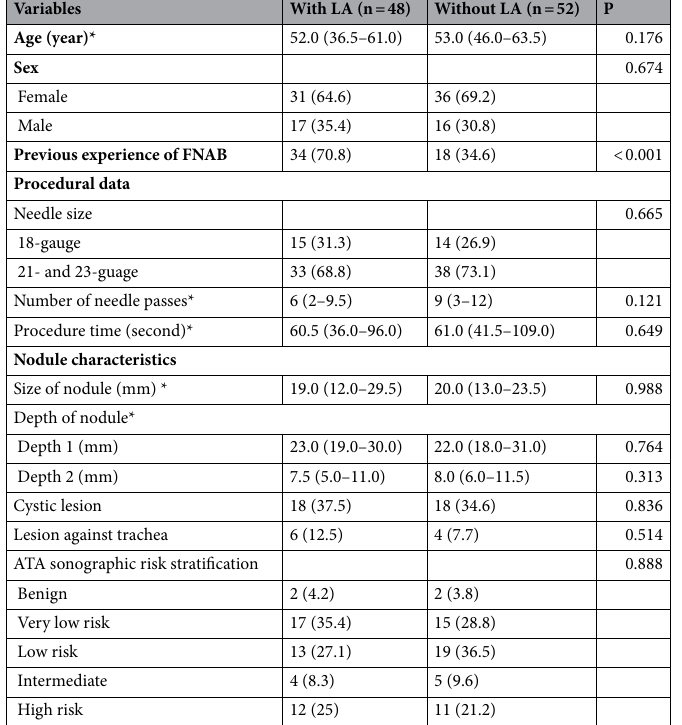
Table 1. Demographics, procedural data, and characteristics of thyroid nodules in the patients undergoing FNAB with and without LA. *Data are presented as counts (percentages) or medians (interquartile ranges). FNAB, fine-needle aspiration biopsy; LA, local anesthesia; ATA, American Thyroid Association; NA, not